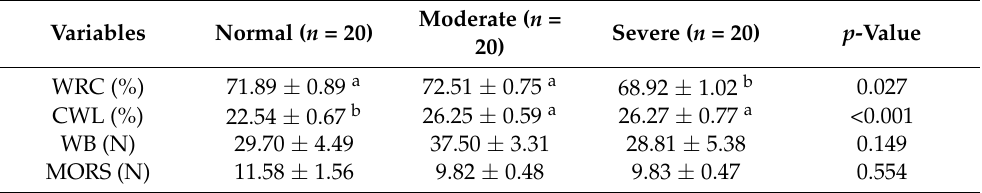
Table 3. Mean values and standard deviation of water retention capacity (WRC), cooking weight loss (CWL) and shear force by Warner–Bratzler (WB) and Meullenet–Owens Razor Shear (MORS) methods of breast meat from broilers affected by WBM.